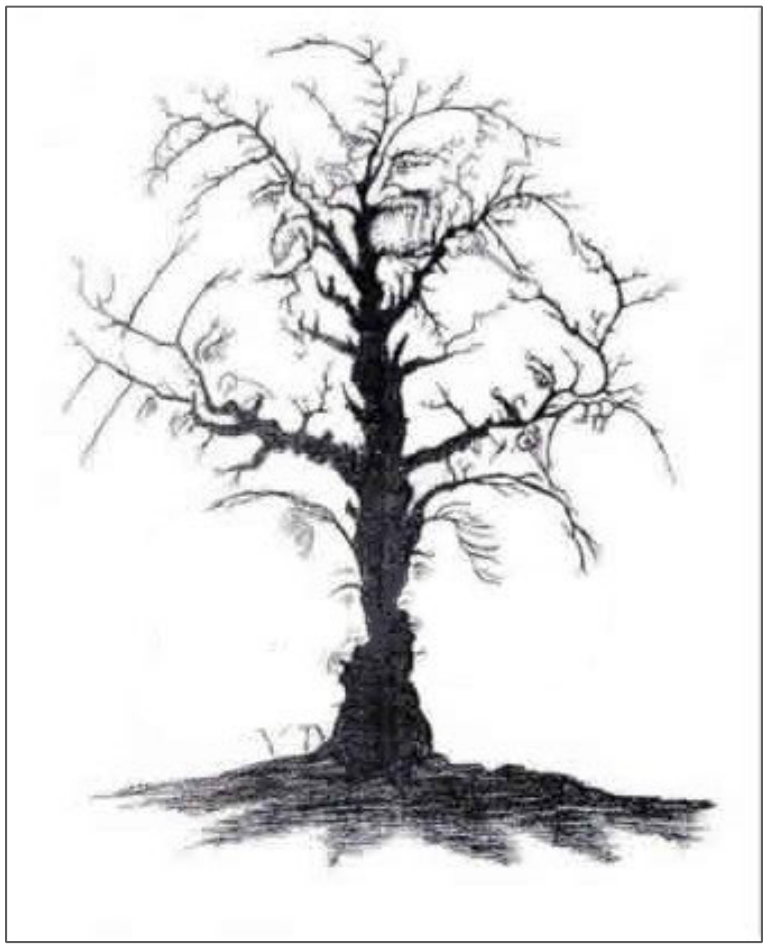
Figure 9. Baby reclining and/or couple viewing stretch of water